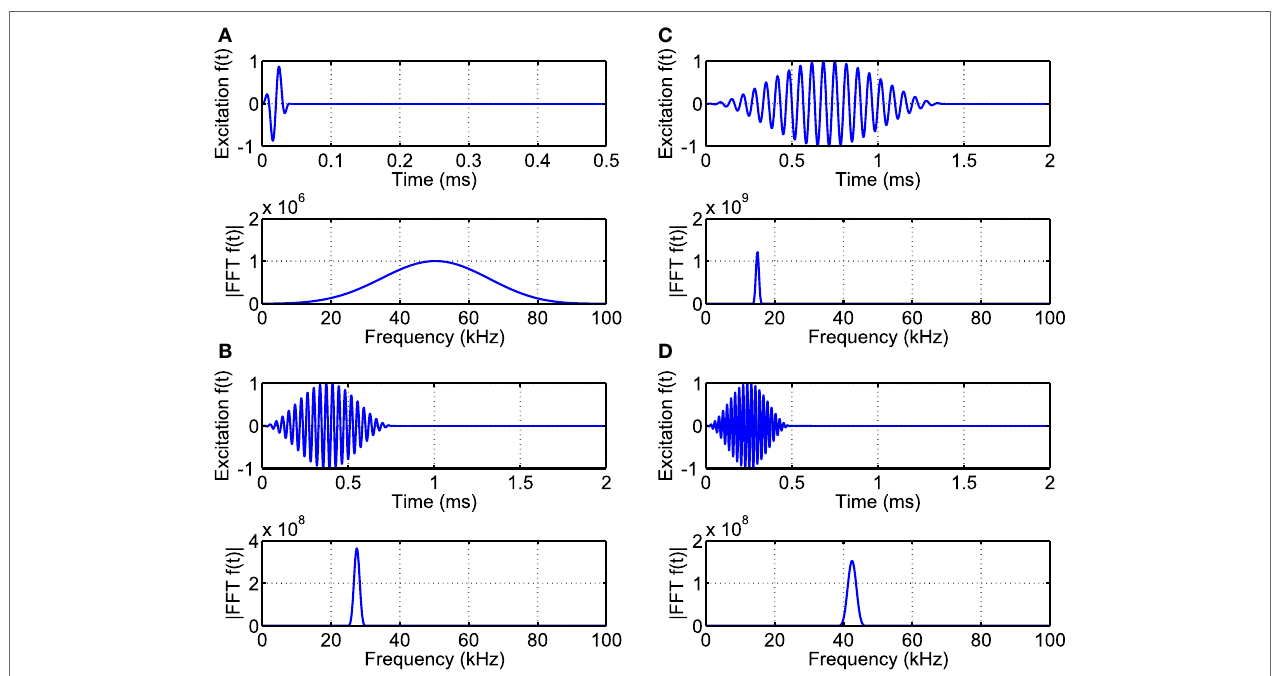
FigUre 6 | Excitation pulses: (a) 2 sine cycles at 50 kHz modulated by a Hanning window and 21 sine cycles at (B) 27.5 kHz, (c) 15 kHz, and (D) 42.5 kHz modulated by a Hanning window.